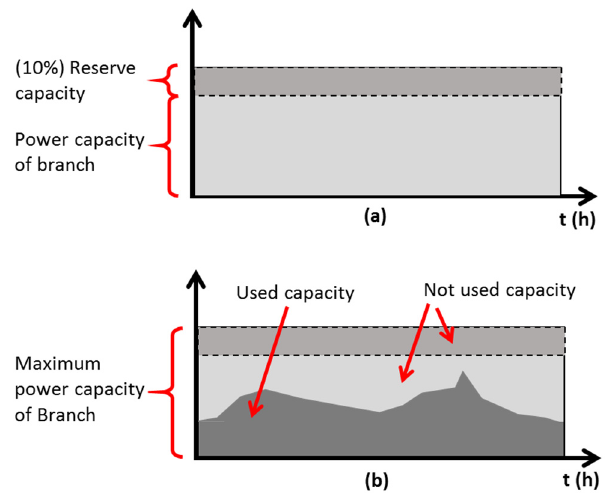
Figure 3. ( a ) Graphical representation of the maximum power capacity of branches showing the power capacity in axis y and the hourly time in axis x . ( b ) Explanation of the daily exploitation capacity of DN (Distribution Network), based on the maximum power capacity of branches, and the hourly used capacity.